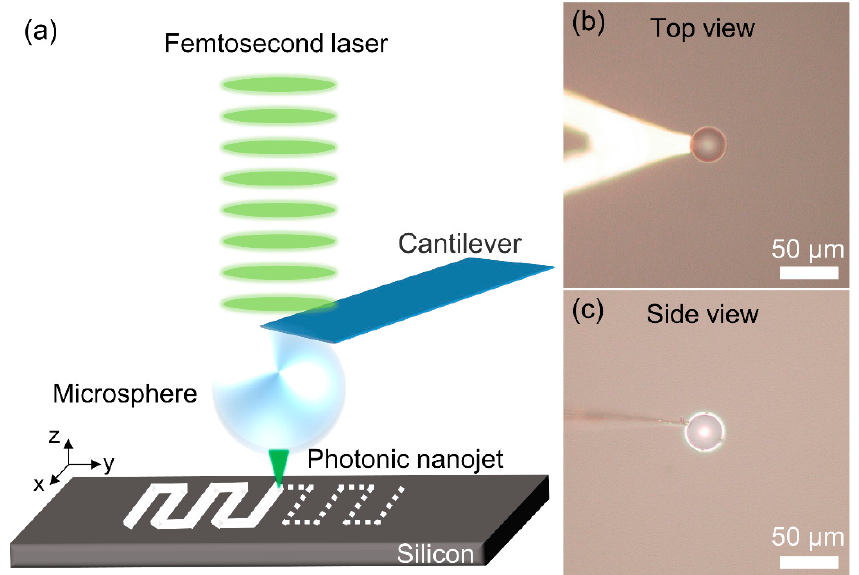
Figure 1. ( a ) Schematic showing the direct writing of silicon oxide patterns on a silicon substrate via a PNJ. ( b ) Top and ( c ) side views of a microsphere attached to the cantilever of an AFM. The diameter of the fused silica microspheres ( n = 1.47) is approximately 22 μ m.